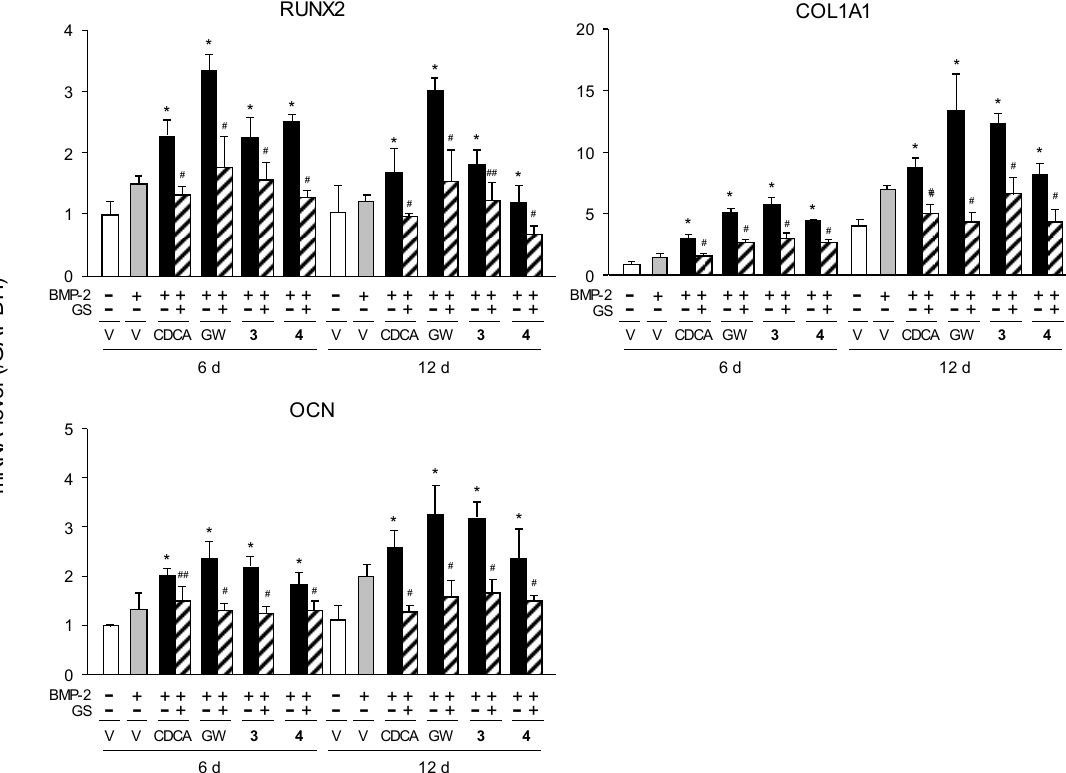
Figure 6. Expression of osteogenic genes during osteoblast differentiation of ST-2 MSCs. The ST-2 MSCs were differentiated into osteoblasts as described in the legend of Figure 5B. Transcription levels of the RUNX2, COL1A1, and OCN genes were measured by qPCR. Data represent as means ± S.D. from three experiments. * p < 0.01, as compared with the BMP-2-treated cells, # p < 0.01, ## p < 0.05, as compared with the FXR agonist-treated cells.